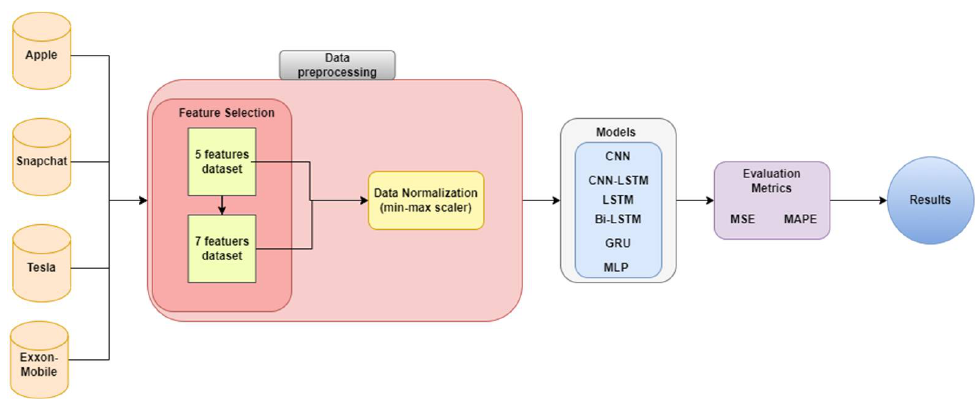
Figure 1. The overall flow diagram of the proposed work .